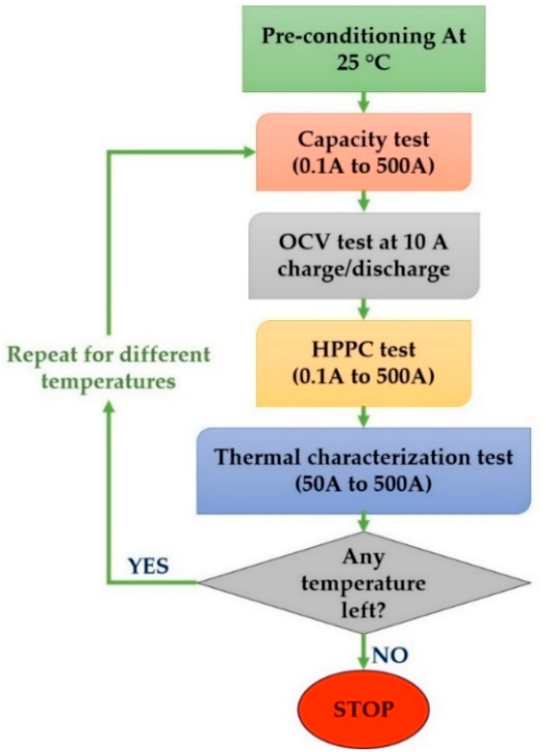
Figure 2. The algorithm used to implement the proposed equivalent circuit.